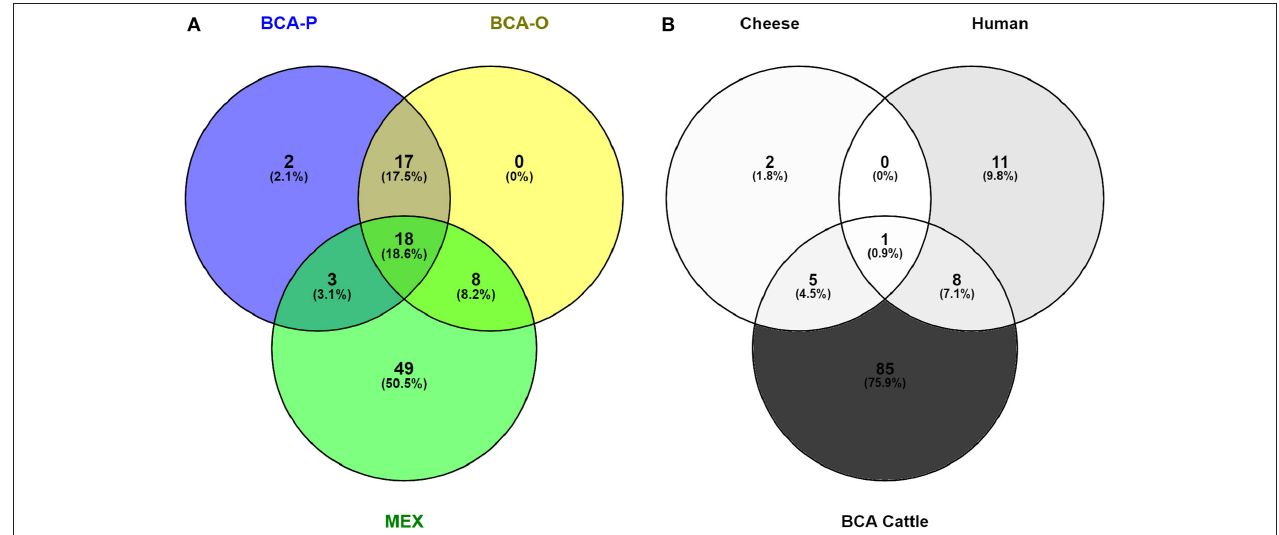
FIGURE 4 | Venn diagrams representing comparisons of M. bovis genotypes (A) identified in Baja California in this study (BCA-P) and previously (BCA-O, MEX) (B) from cattle, humans and